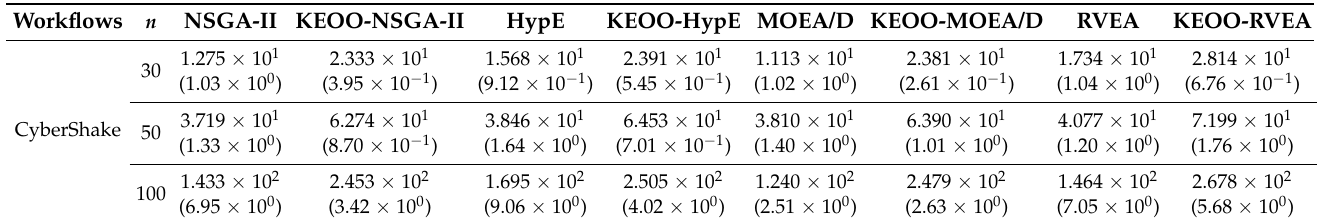
Table 6. Execution time (second) of the eight